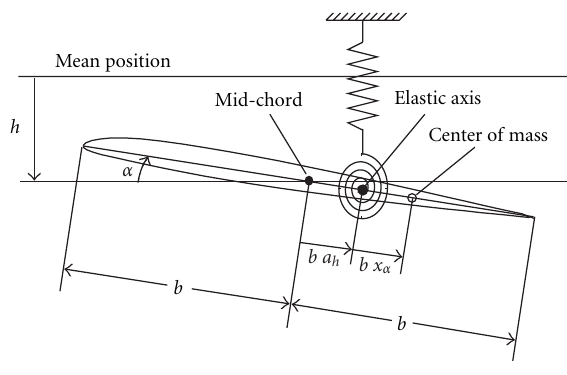
Figure 1: Schematic of the airfoil.